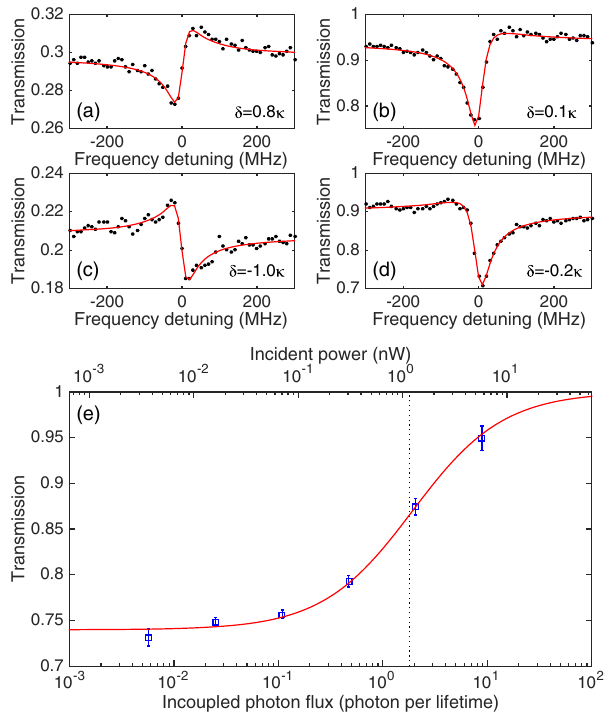
FIG. 4. (a) – (d) Response of the resonant cavity-molecule system as a function of laser frequency detuning for four different cavity detunings by the amounts shown in each legend. See Supplemental Material for fitting procedure [24]. (e) The re- sponse of the system as a function of the excitation power. The dotted vertical line indicates saturation parameter S ¼ 1 . In these measurements the finesse has dropped to about 100 due to condensation of residual gases (see Supplemental Material